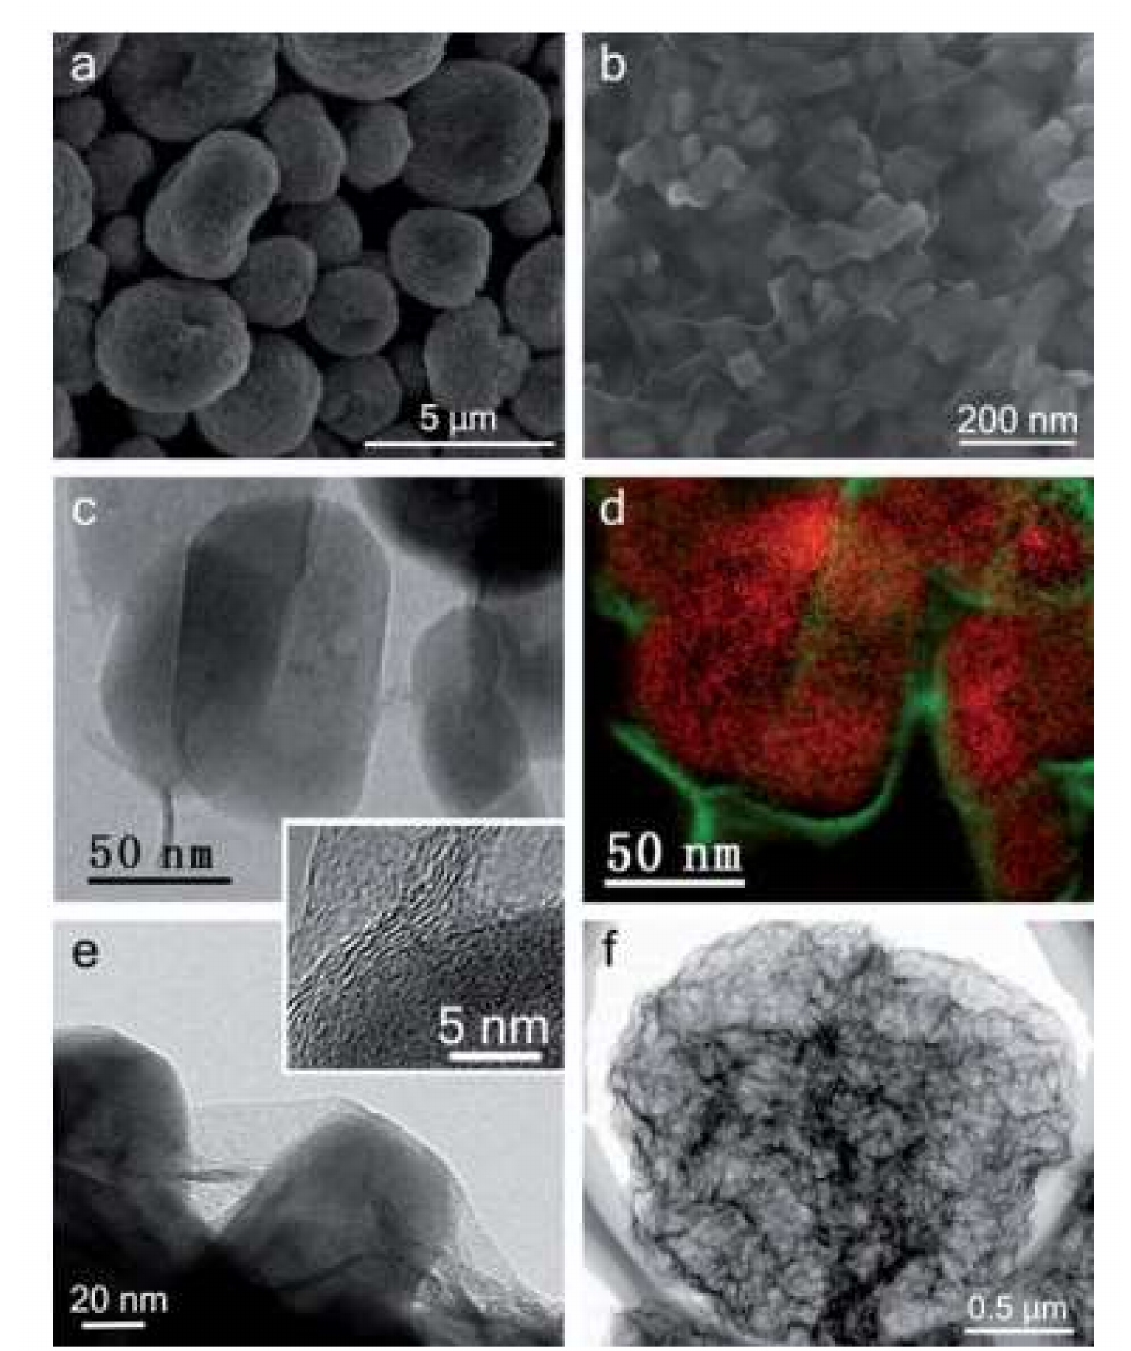
Figure 25. Illustration of the preparation process and the microscale structure of LFP/graphene composite. ( a , b ) SEM images show an overview of the LFP/G particles, ( c ) TEM image of the LFP/G particles, ( d ) corresponding elemental map using EELS of the same area showing graphene-sheets wrapping on LFP nanoparticles, where red represents the LFP nanoparticles, obtained from the P L-edge, and the green represents graphene sheets, obtained from C K-edge, ( e ) TEM image on the edge of individual microspheres. The inset is a high-resolution TEM image illustrating the 3–5 monolayer thickness of the graphene sheets on the surface of an individual LFP nanoparticle, and ( f ) TEM image showing a 3D graphene network obtained by removing LFP nanoparticles with an HCl solution. Adapted and reproduced with permission from Ref. [108]. Copyright 2011 Royal Society of